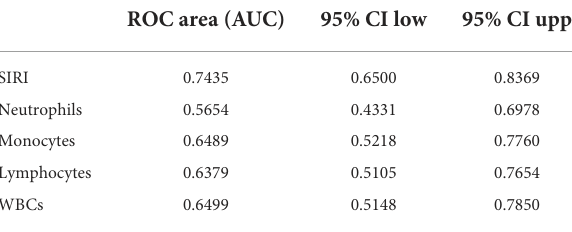
TABLE 6 Receiver operating curve (ROC) for prediction for 30-day mortality in TBI patients after PSM. ROC area (AUC) 95% CI low 95% CI